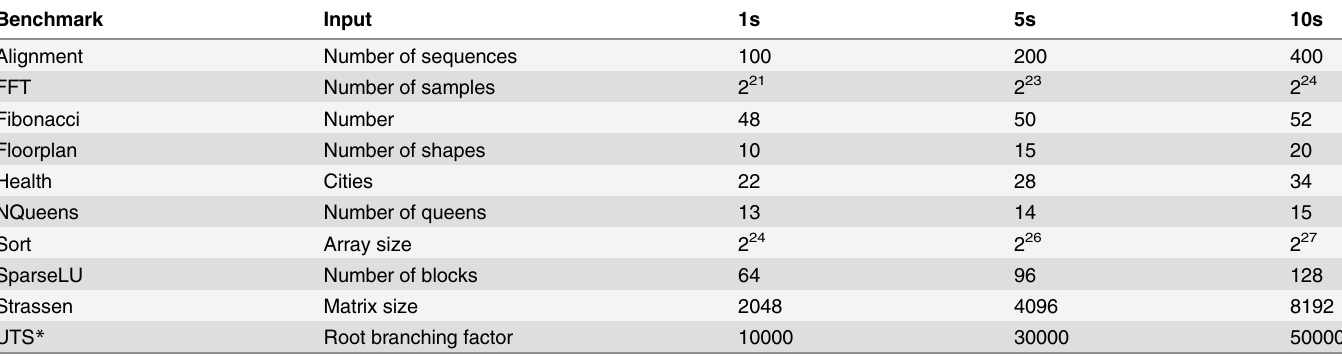
Table 4. Data sizes to study BOTS input sensitivity. Benchmark